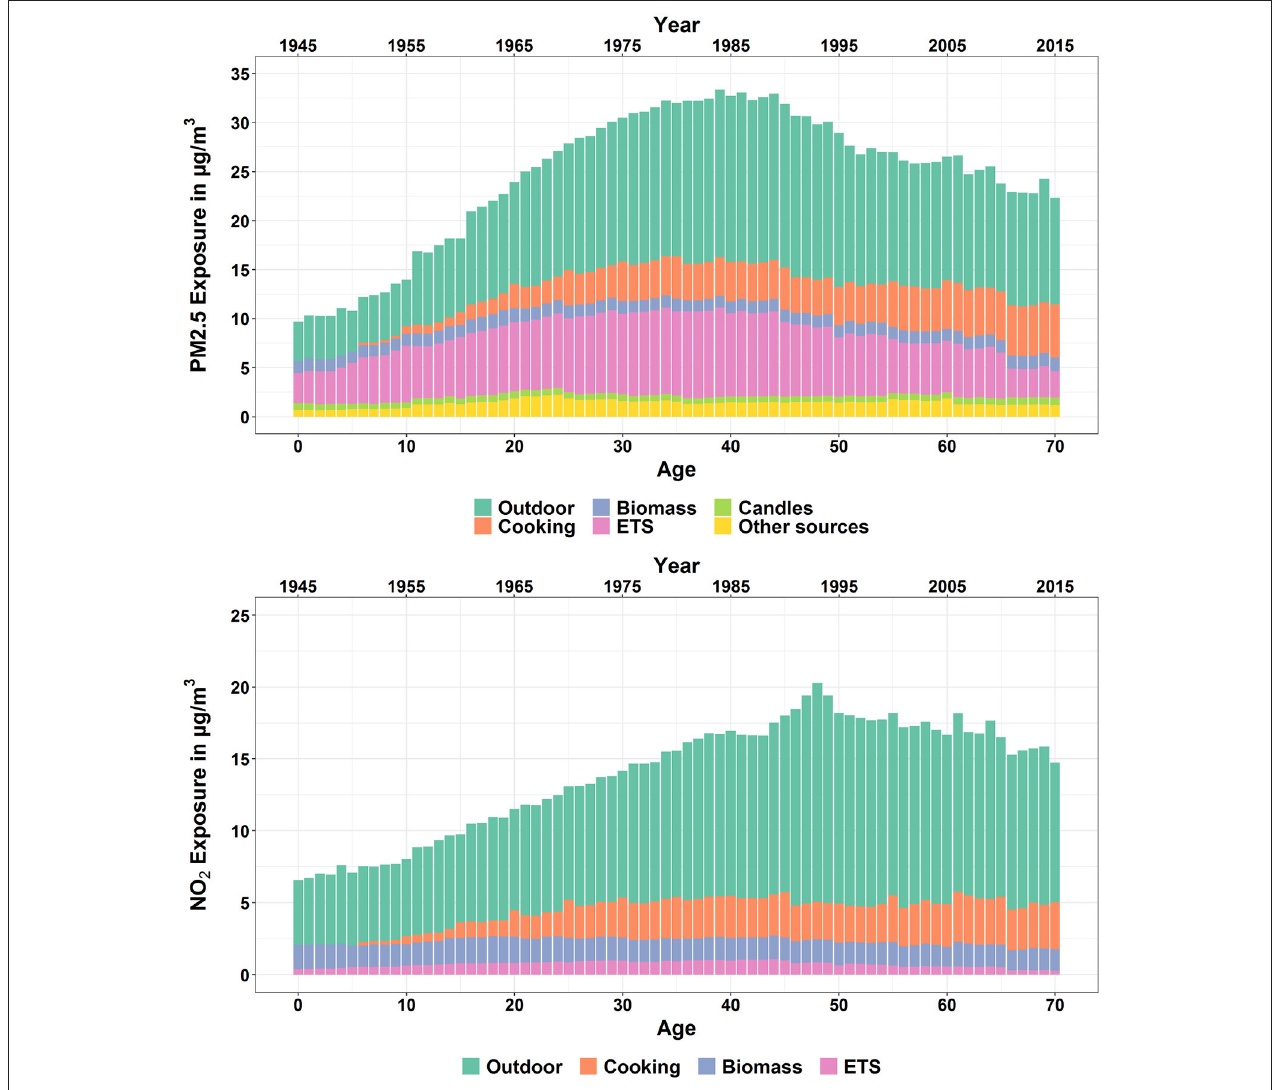
FIGURE 11 | Temporal course of the average lifelong exposure to PM2.5 (upper) and NO 2 (lower) for an 70-year-old European differentiated by source, including infiltration from outdoors, biomass, candles, cooking, ETS (passive smoking), and other